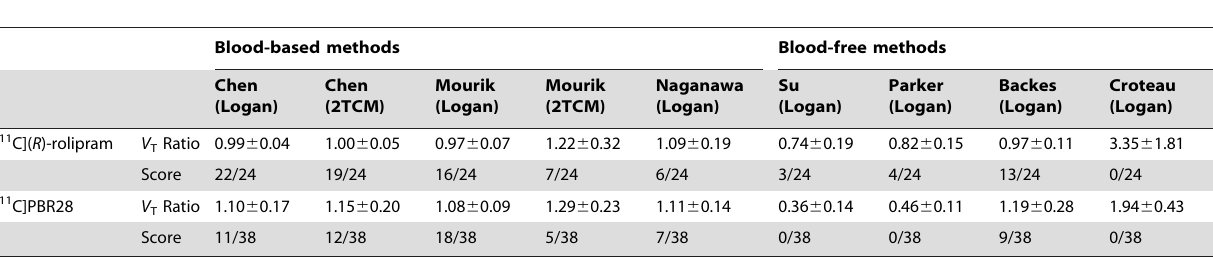
Table 2. Image/blood V T ratios (mean 6 SD) and scores calculated for each method.